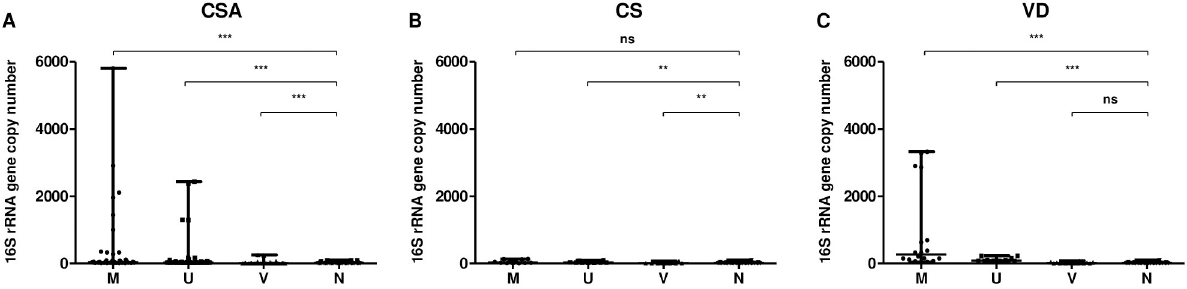
Fig 3. 16S rRNA gene copy number in fetal membranes, umbilical cords, chorionic villi and extraction blanks collected after C-section with (A) or without (B) an Alexis 1 or after vaginal delivery (C). CSA: cesarean section using an Alexis 1 ; CS: cesarean section; VD: vaginal delivery; M: fetal membranes; U: umbilical cord; V: chorionic villi. ns: non-significant; �� : P < 0.01; ��� : P < 0.0001.